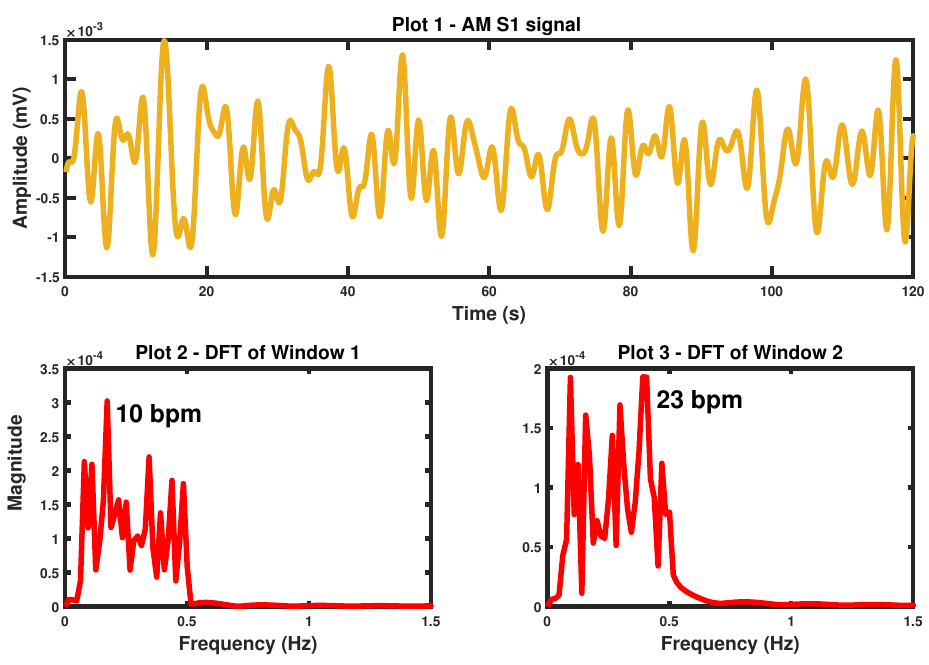
Figure 7. DFT analysis of the AM S1 signal on b001: Plot 1 shows the obtained AM S1 signal. Plots 2 and 3 depict the DFT analysis of the first two respiratory